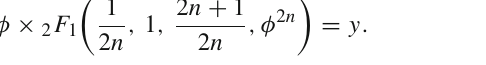
Fig. 5 Plot of potential U ( y ) for a = 1, U 0 = 0 and ψ 0 = 1 with ϕ = 0 . 8 (solid line), ϕ 0 line)